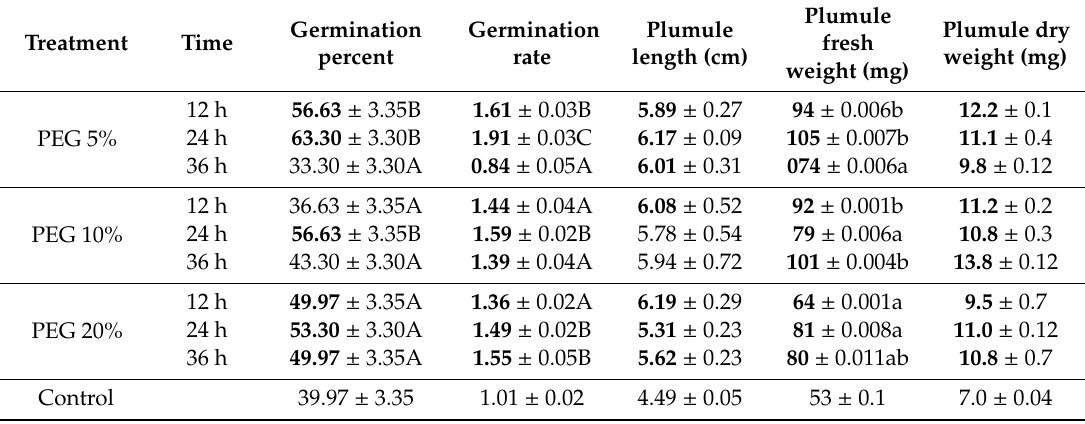
Table 2. Comparative analysis of caraway seed priming with PEG on germination and seedling characteristics in the soil